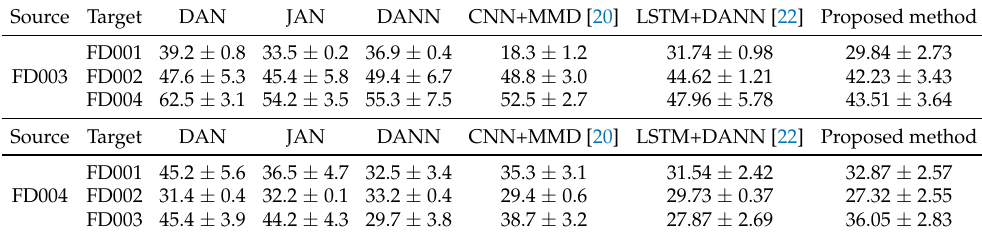
Table 5. RMSE in different